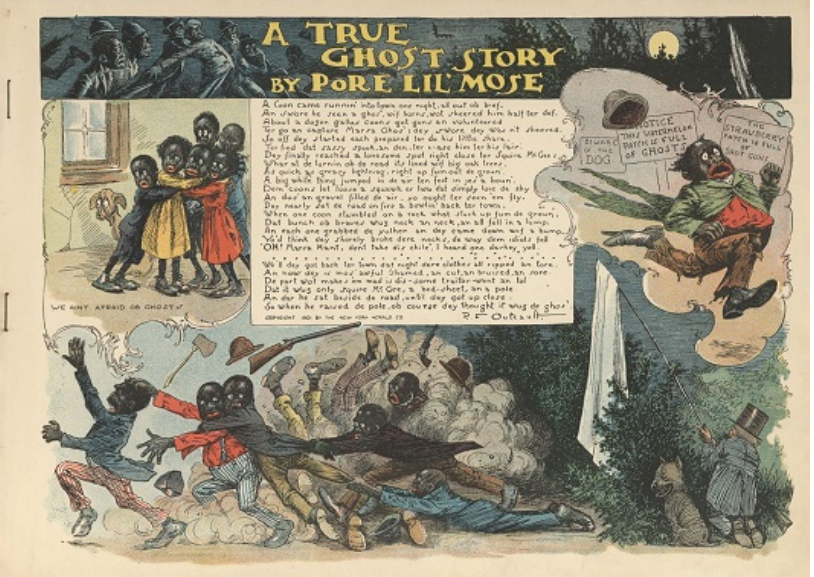
Figure 1. Image of page 4 of Pore lil Mose. Available through Michigan State University Digital Collections: https://d.lib.msu.edu/gnn/1449 (accessed on 4 May 2022).